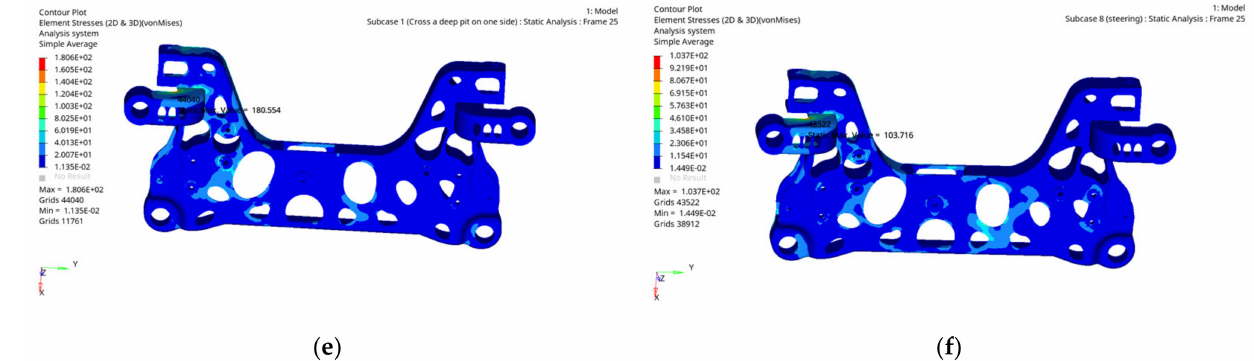
Figure 5. Cloud diagram of stress results of aluminium alloy front subframe under some typical working conditions. ( a ) Forward braking condition. ( b ) Backward braking condition. ( c ) Forward emergency braking condition. ( d ) Backward emergency braking condition. ( e ) Over one side deep pit condition. ( f ) Ultimate steering condition.